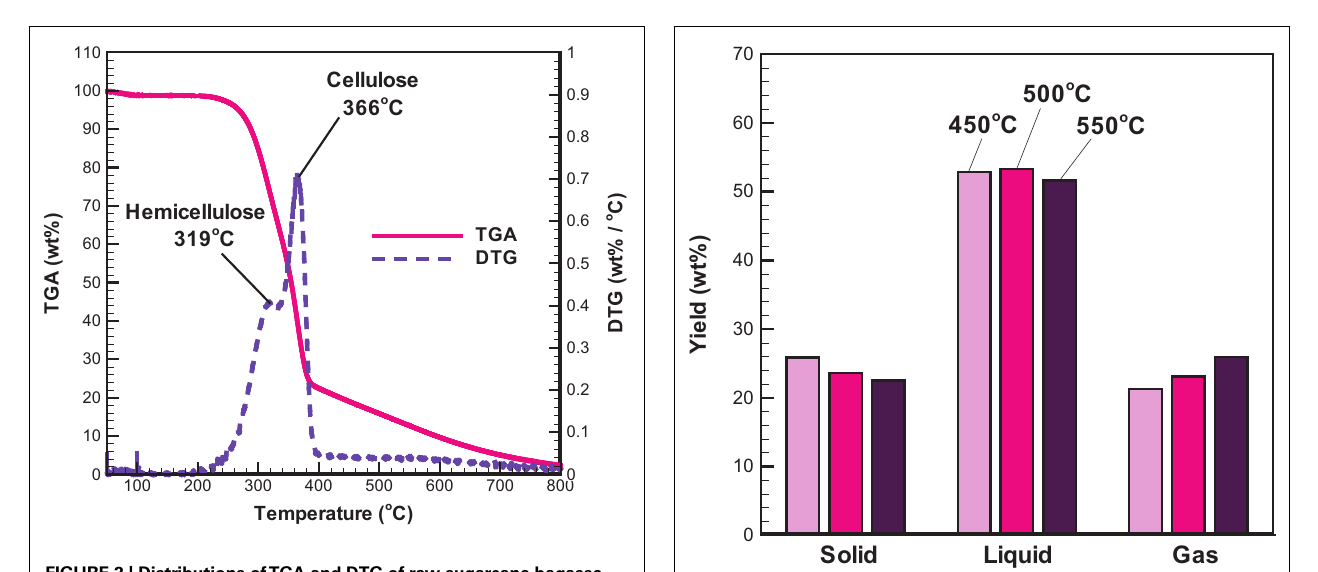
FIGURE 2 | Distributions ofTGA and DTG of raw sugarcane bagasse .